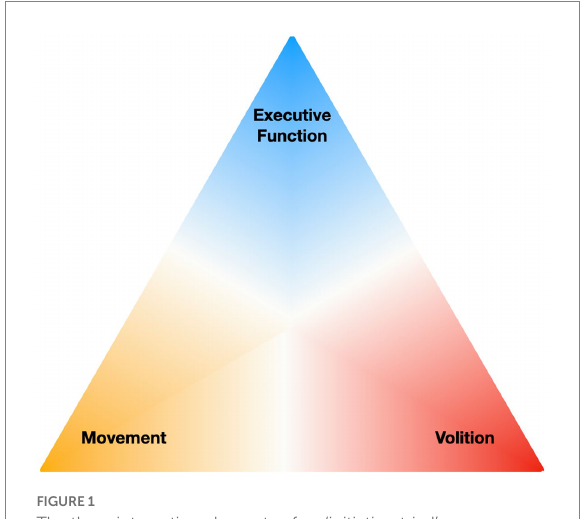
FIGURE 1 The three interacting elements of an ‘initiation